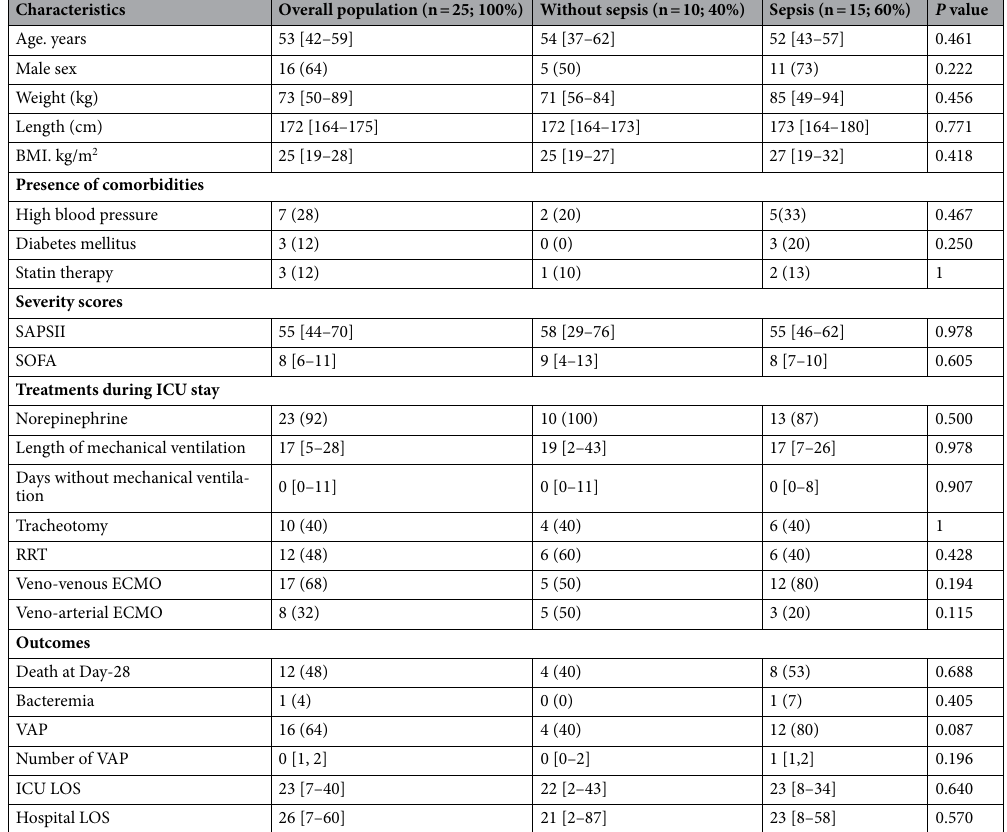
Table 3. General characteristics and outcome of the patients with and without sepsis. Continuous variables are expressed as the median and interquartile range (IQR) and were compared using the Mann–Whitney U test. Categorical variables are expressed as n (%) and were compared with Fisher’s exact test; BMI: body mass index; ECMO: extracorporeal membrane oxygenation; LOS: length of Stay; RRT: renal replacement therapy; SAPS II: simplified acute physiology score II; SOFA: sepsis-related organ failure; VAP: ventilator-associated